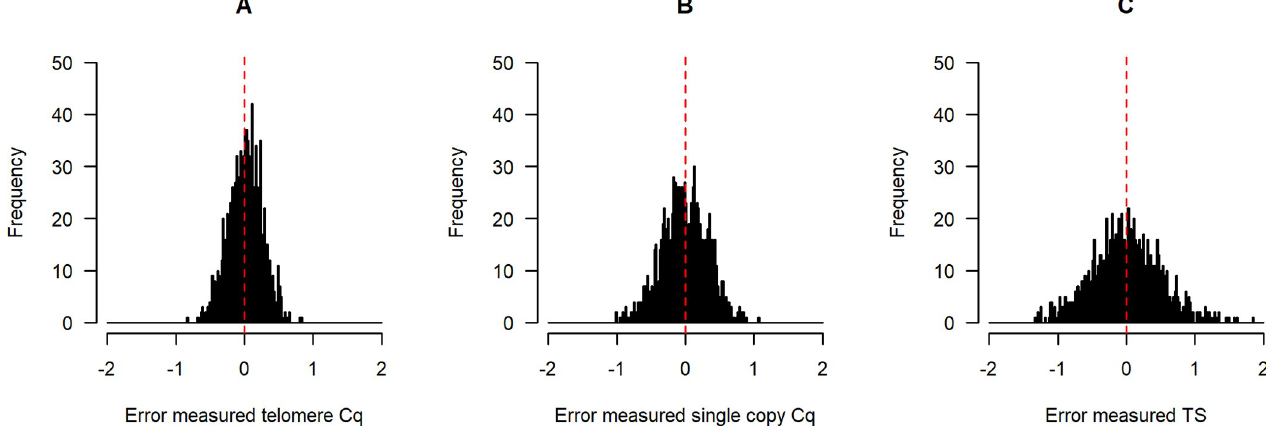
Fig 2. Distribution of errors in Cq values (telomere, A, and single-copy gene, B) and the resulting TS ratio (C) in simulated data . Data are generated with n = 1000 and σ ε s = σ ε t = 0.05. The scale in each case is standard deviations of the ideal (error-free) quantity in the simulated